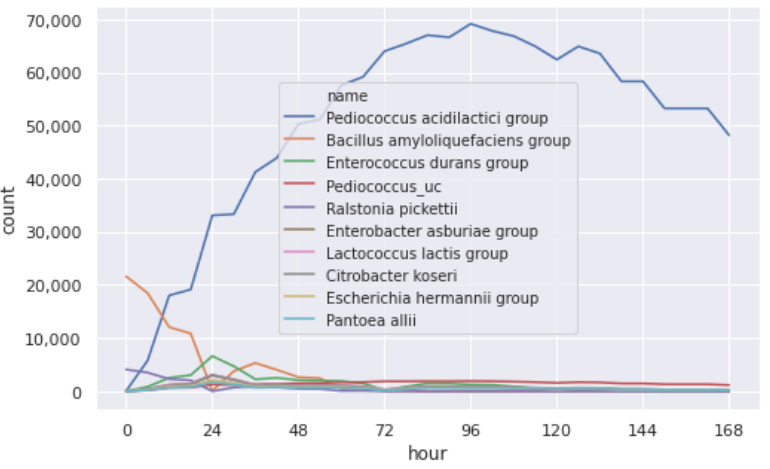
Figure 8. Imputed distribution of the microbial community.